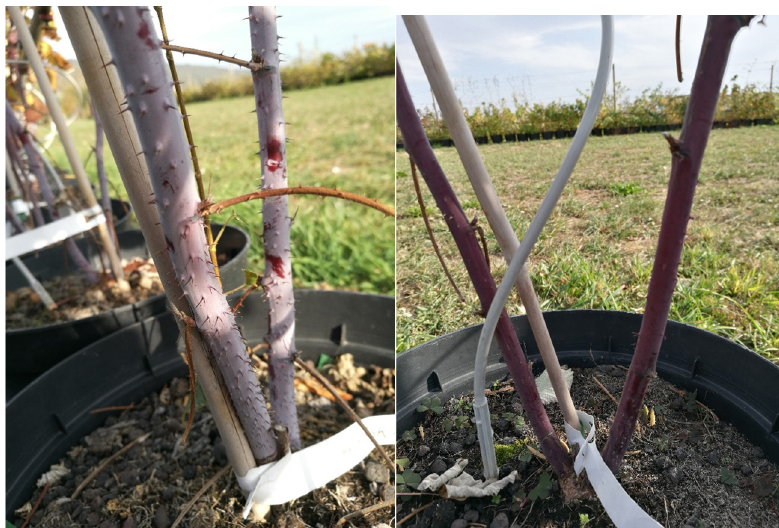
Figure 1. Two individuals from the population showing different waxy cane phenotypes: waxy bloom cane (whitish-colored cane, left ) and no waxy bloom ( right ) on one-year-old canes in late autumn. There is a strong visible difference between the two categories.